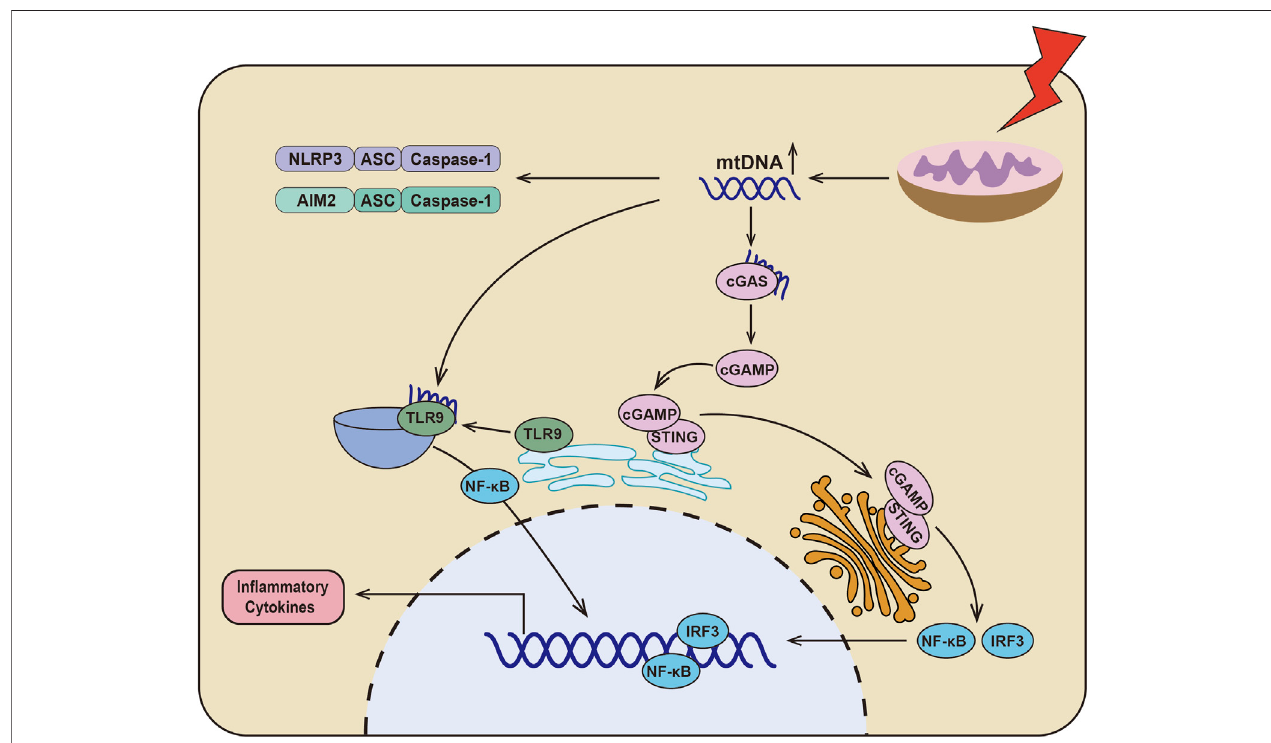
FIGURE 1 | Schematic depicting the relationship between dysfunctional mitochondria and in fl ammation. In DKD, there are serious mitochondrial dysfunction and mtDNA leakage,whichcoulddirectlyactivateNLRP3in fl ammasome andAIM2in fl ammasome.Additionally, mtDNAcouldbesensedbycGAS tocatalyzeATPandGTP into the second messenger cyclic GMP-AMP (cGAMP). And then cGAMP binds to STING and translocation of the Golgi apparatus to initiate IRF3 and canonical NF- κ B signaling pathway. Furthermore, mtDNA activates TLR9/NF- κ B signaling pathway by binding to TLR9, which results in the production of in fl ammatory